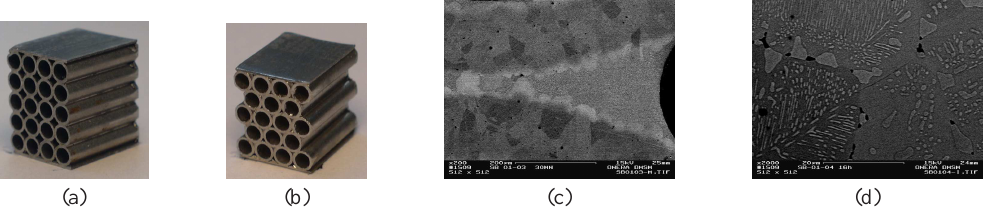
Fig. 1. Sandwich structure with a) a square stacking core b) an hexagonal stacking core c) SEM of a braze joint (medium grey) linking two neighbour tubes d) zoom on the eutectic structure in the